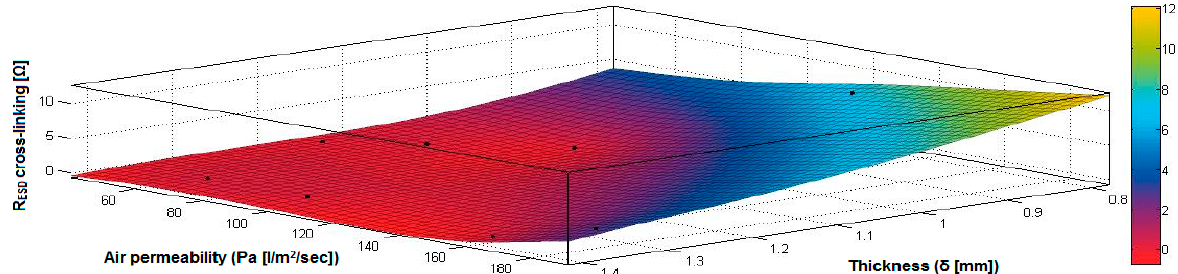
Figure 32. 3D representation R ESD after crosslinking = f(M, δ ) samples preliminarily treated in RF plasma O 2 using RF 2 generator and power 100 W.